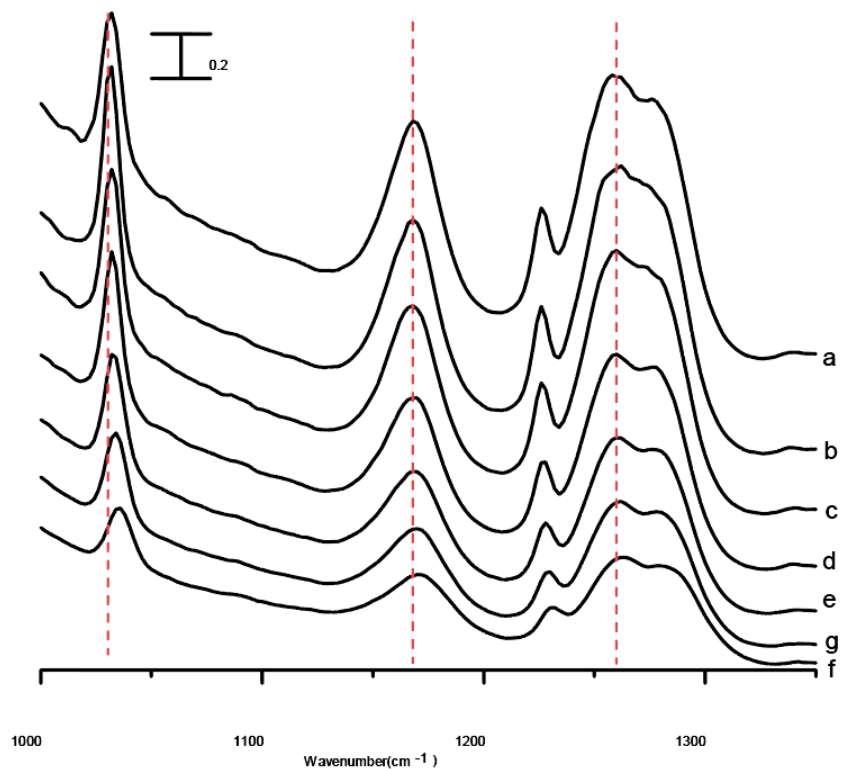
Figure 6. IR spectra of the mixture after five washes with ethanol obtained under ambient pressure (curve a) and at 0.4 (curve b), 0.7 (curve c), 1.1 (curve d), 1.5 (curve e), 1.8 (curve f), and 2.5 GPa (curve g). Relative intensities of the IR bands are given in increments of 0.2; the scale bar is displayed in the upper left corner of the figure.